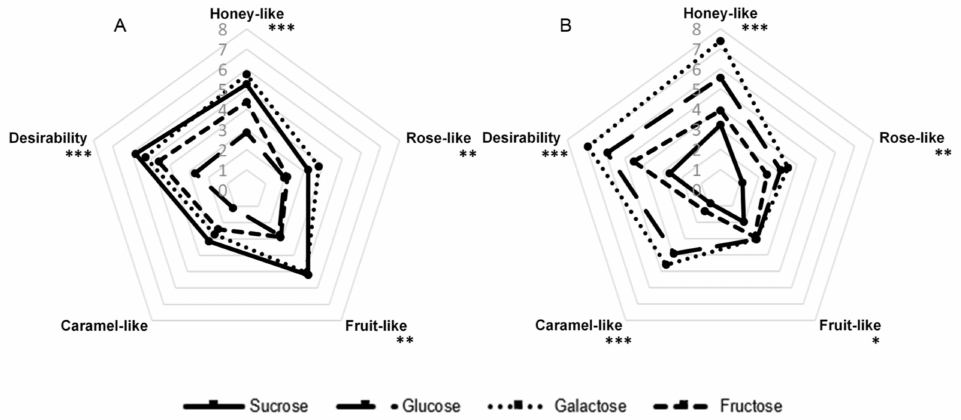
Figure 1. Sensory profiles of post-fermentation products from flask cultures with ( A ) sour whey and ( B ) buttermilk for various types of sugars. * p < 0.05; ** p < 0.01; *** p <